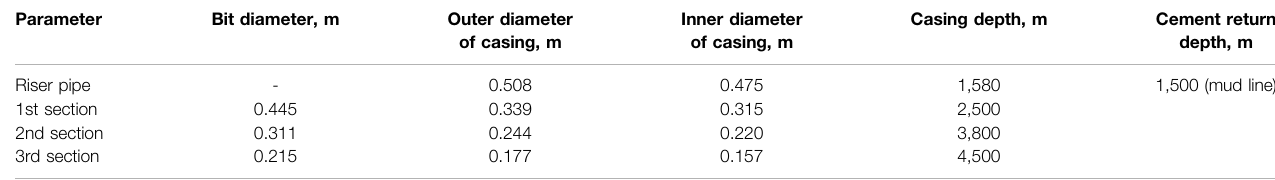
TABLE 2 | Wellbore structure and casing parameters.